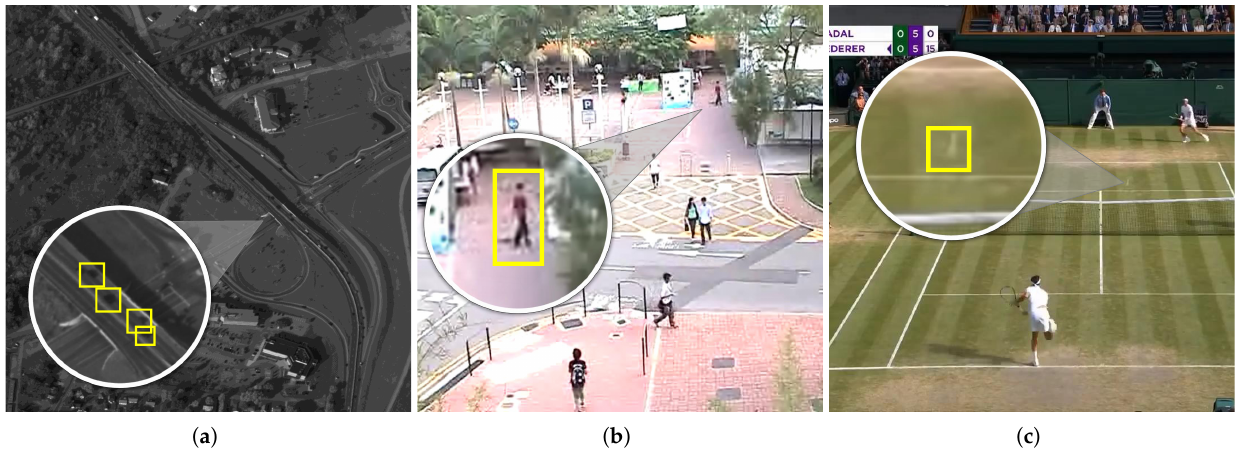
Figure 6. The three test scenarios considered in this work: ( a ) aerial surveillance, WPAFB 2009 dataset; ( b ) civilian surveillance, CUHK dataset; ( c ) Tennis ball tracking, custom dataset. In each image a sub-area is zoomed to highlight the small size of the target objects.